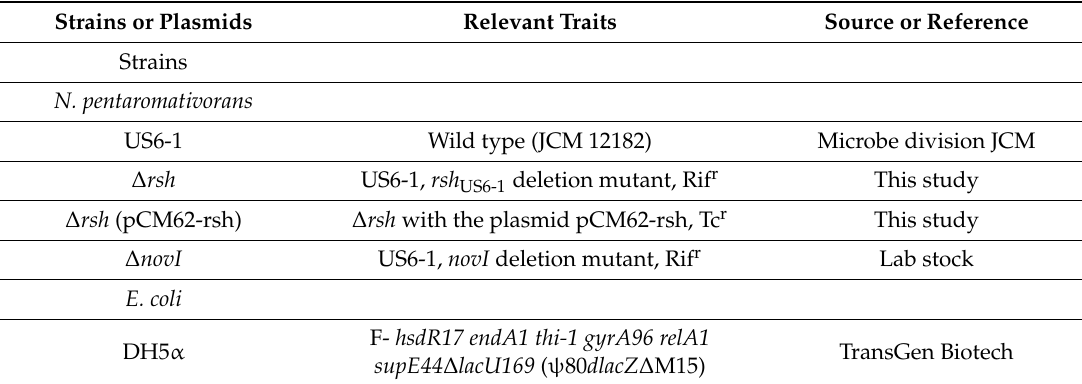
Table 2. Bacterial strains and plasmids used in this